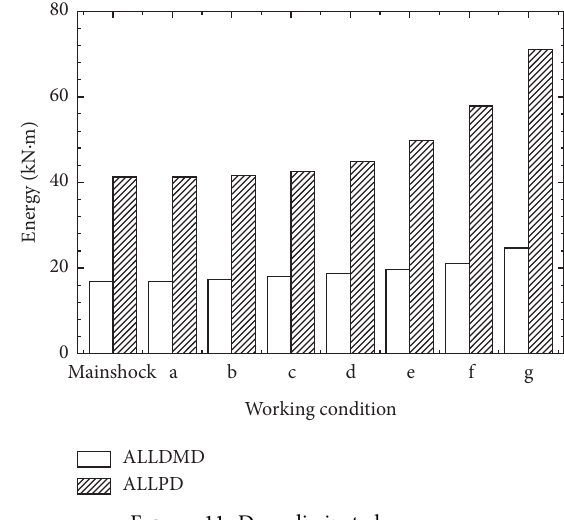
Figure 11: Dam dissipated energy.